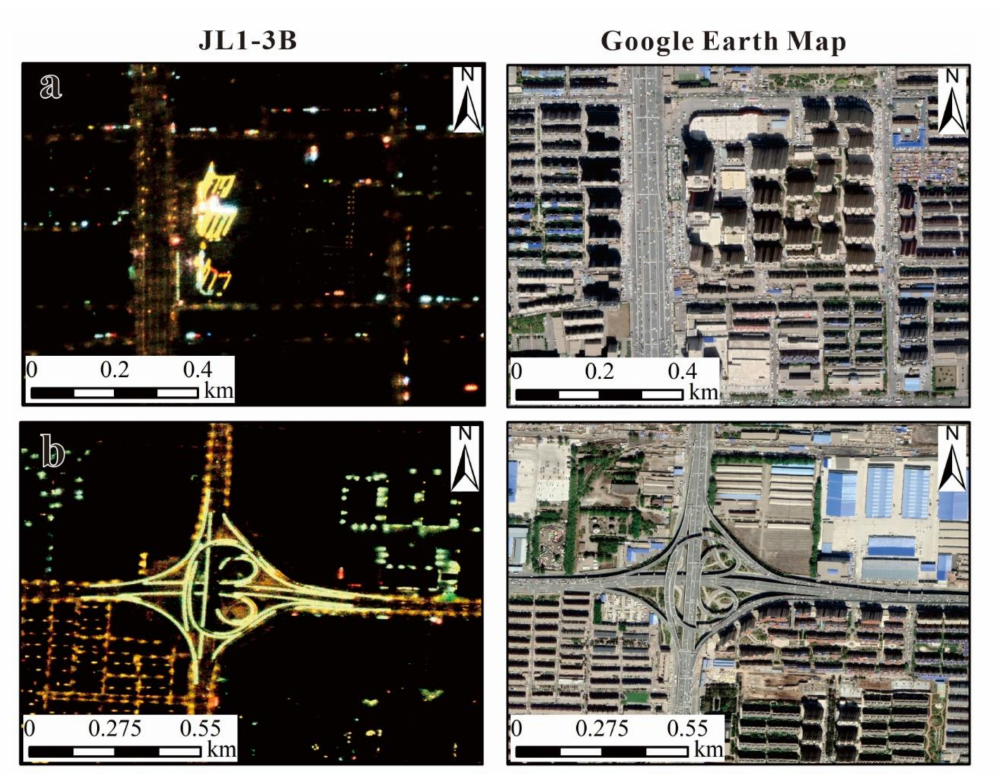
Figure 11. Limitations of JL1-3B NTL data: JL1-3B images (left panel), Google earth map (right panel) of two selected regions, including major building area ( a ), tra ffi c lanes ( b